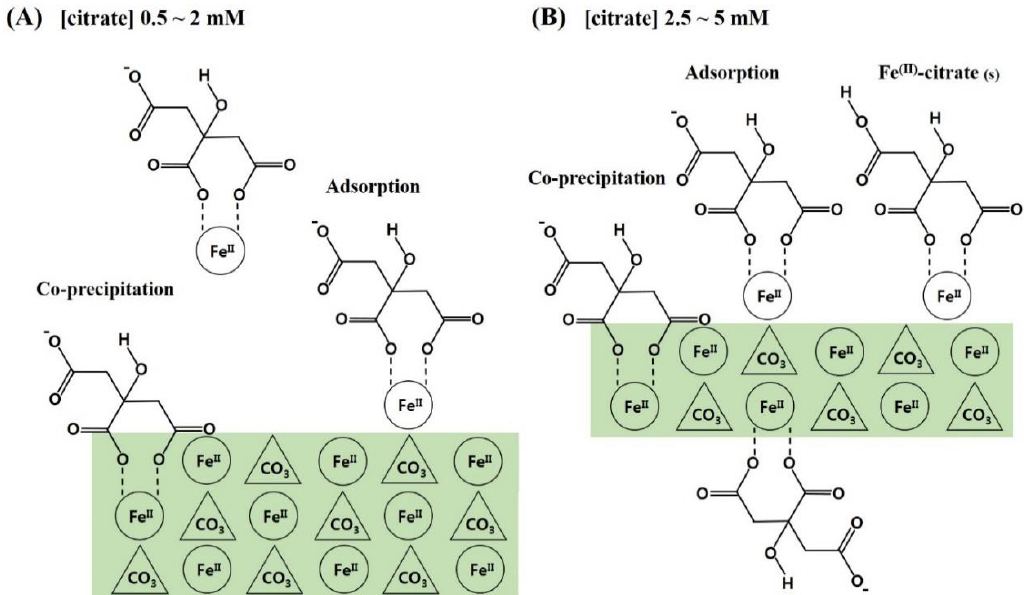
Figure 5. Schematic illustrations for the formation of citrate / FeCO 3 nanocomposites (CF-NCs). ( A ) Adsorption and co-precipitation of (Fe 2 + citrate) − complexes at the surface of larger siderite crystal, ( B ) Adsorption and co-precipitation of (Fe 2 + citrate) − complexes at the surface of smaller siderite crystallite with surface precipitation of some Fe(II)-citrate (s) (modified from Lee and Reeder, 2006) [38].